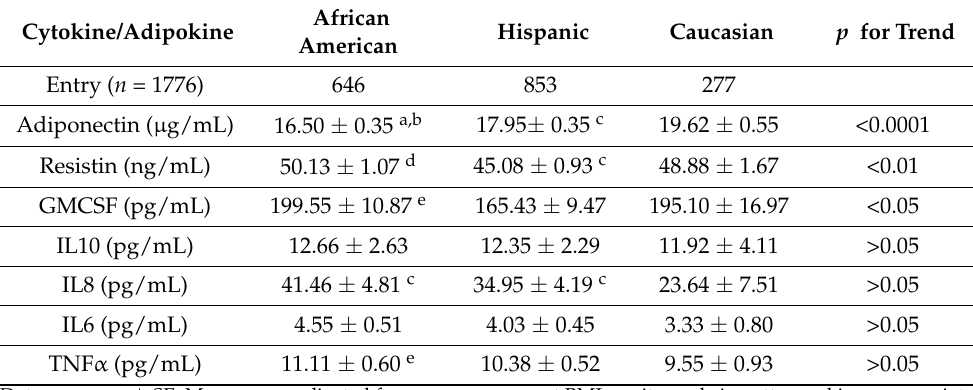
Table 3. Differences in cytokine/adipokine concentrations by ethnicity. Cytokine/Adipokine